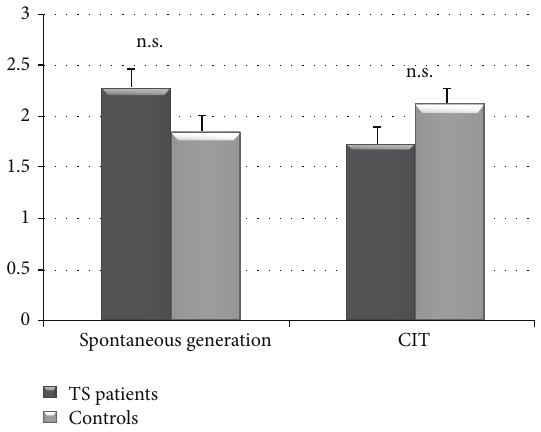
Figure 1: Correct responses produced by TS patients and in control subjects in spontaneous counterfactual generation test and counterfactual inference test (CIT).